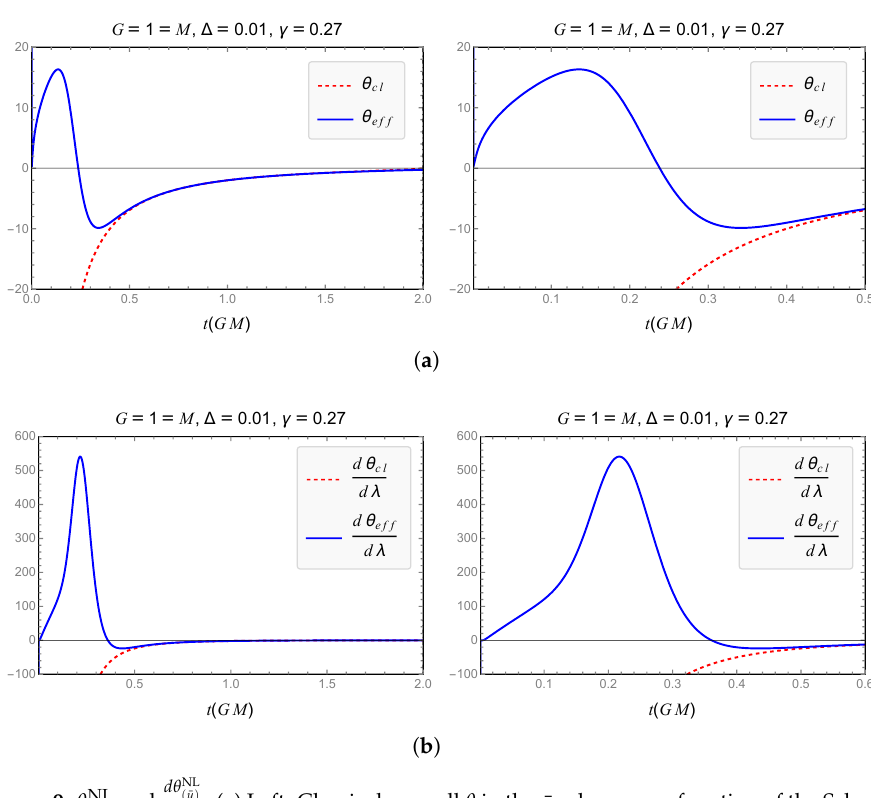
d θ NL ( ¯ µ ) Figure 9. θ NL and . ( a ) Left: Classical vs. null θ in the ¯ µ scheme as a function of the Schwarzschild ( ¯ µ ) d λ time t . The effective expansion θ NL goes to zero as t → 0. Right: Close up of the left figure close to ( ¯ µ ) t = 0. ( b ) Left: Classical vs. null d θ in the ¯ µ scheme as a function of the Schwarzschild time t . The d λ d θ NL ( ¯ µ ) goes to zero as t → 0. Right: Close up of the left figure close to t = effective d λ